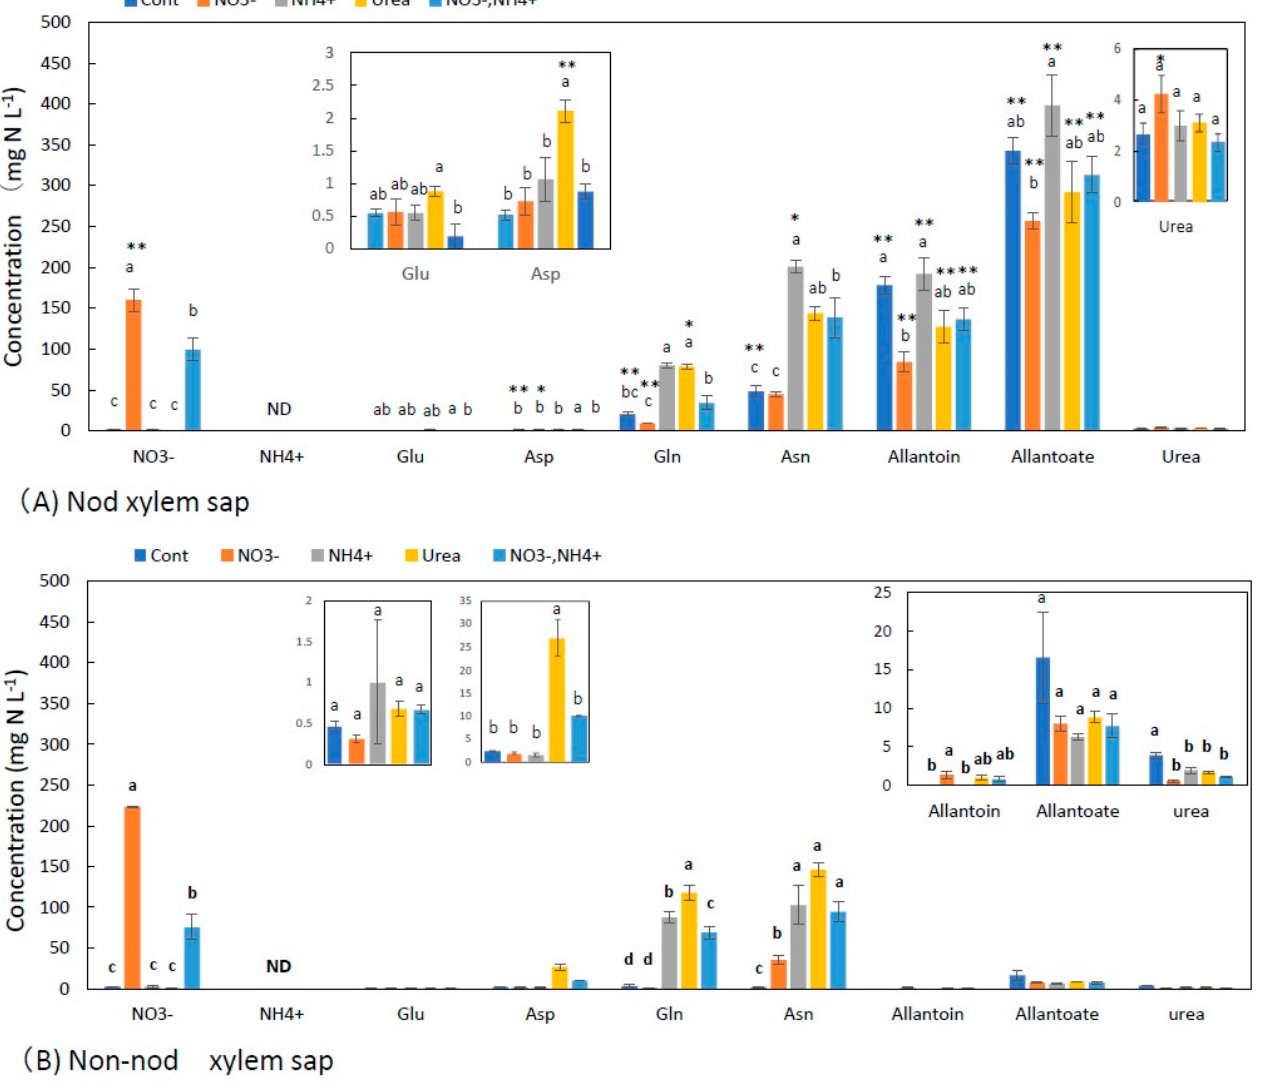
Figure 2. Concentrations of the principal N metabolites in the xylem sap of nodulated ( A ) and non-nodulated ( B ) soybean plants treated with various N compounds. Treatments: Cont, control with N-free solution; NO 3 − , 5 mM KNO 3 ; NH 4+ , 2.5 mM (NH 4 ) 2 SO 4 ; urea, 2.5 mM urea; NO 3 − + NH 4+ , 2.5 mM KNO 3 + 1.25 mM (NH 4 ) 2 SO 4 . N = 3. Average ± standard error. The different letters on the top of